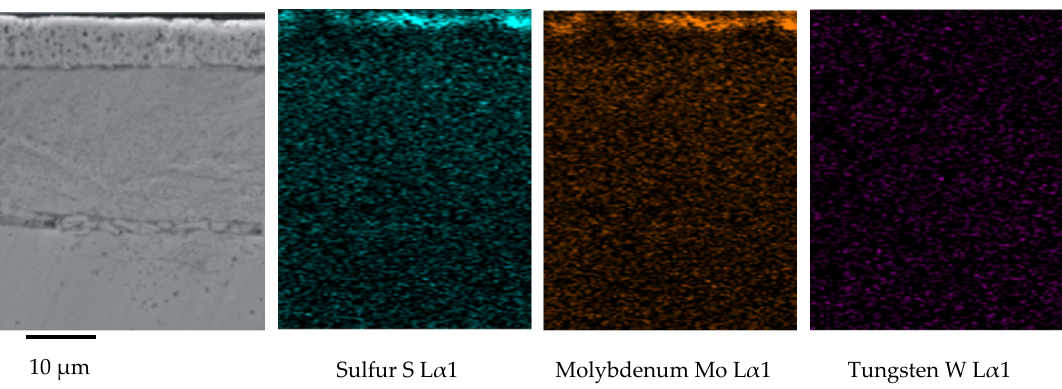
Figure 2. SEM Cross Sections and corresponding EDS maps of S, Mo and W distribution for layer option A.